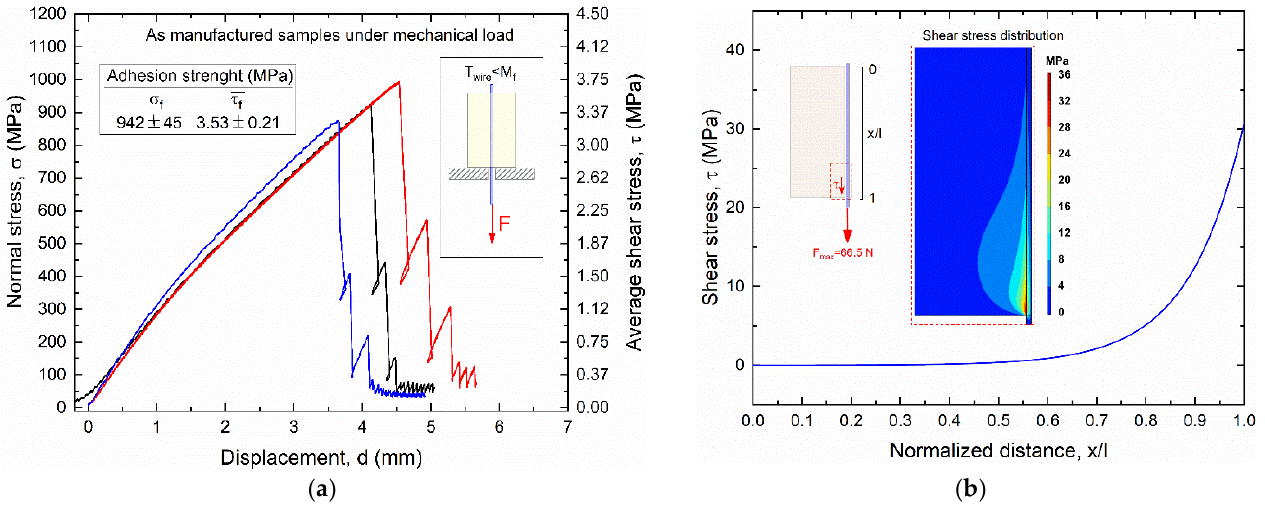
Figure 11. Results of static pullout tests of as manufactured samples subjected to mechanical loading (load case #1): ( a ) experimental stress vs. displacement curves obtained from three different samples; ( b ) FE results of the shear stress distribution at the wire – resin interface along the contact length at the pullout force F max = 66.5 N.